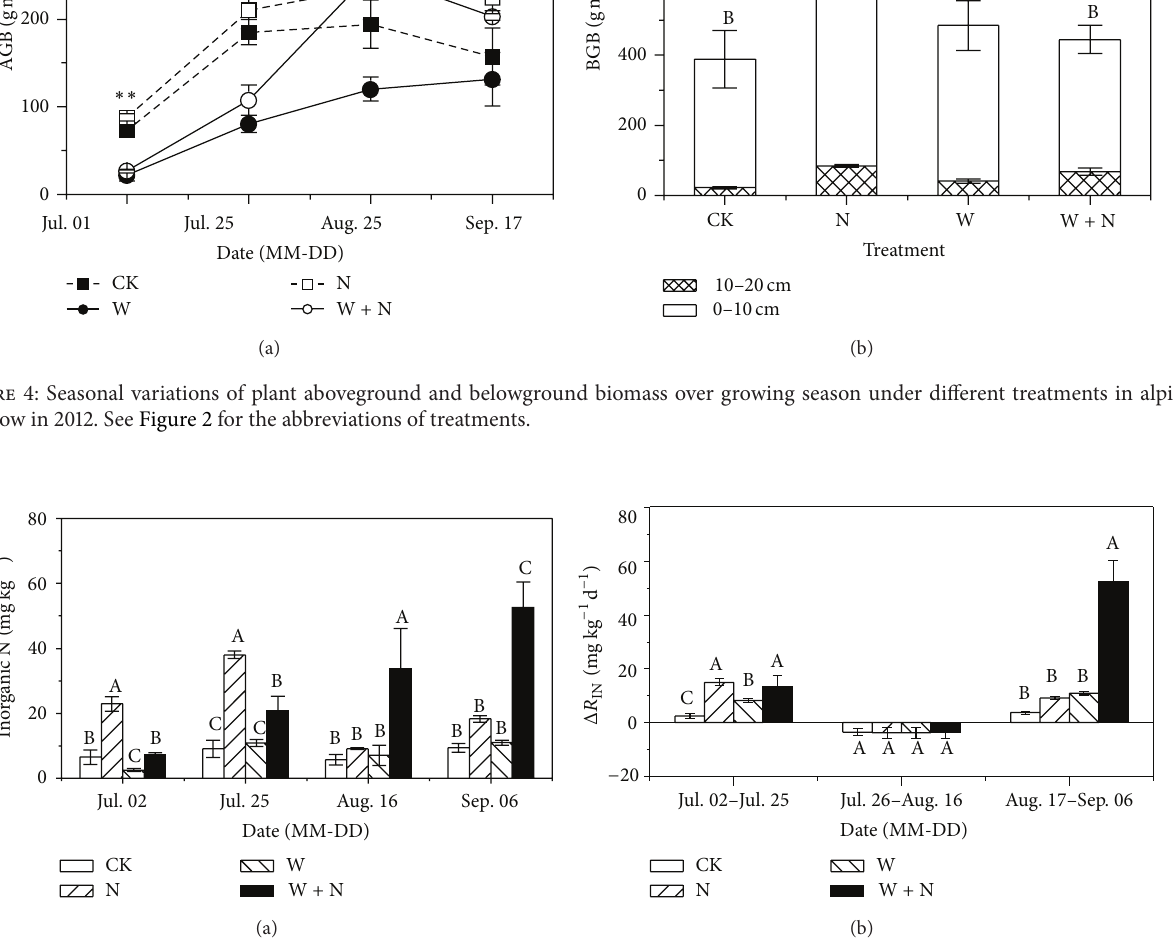
Figure 5: Seasonal variations of soil inorganic N (a) and soil net N mineralization (b) over growing season under different treatments in alpine meadow in 2012. See Figure 2 for the abbreviations of treatments.